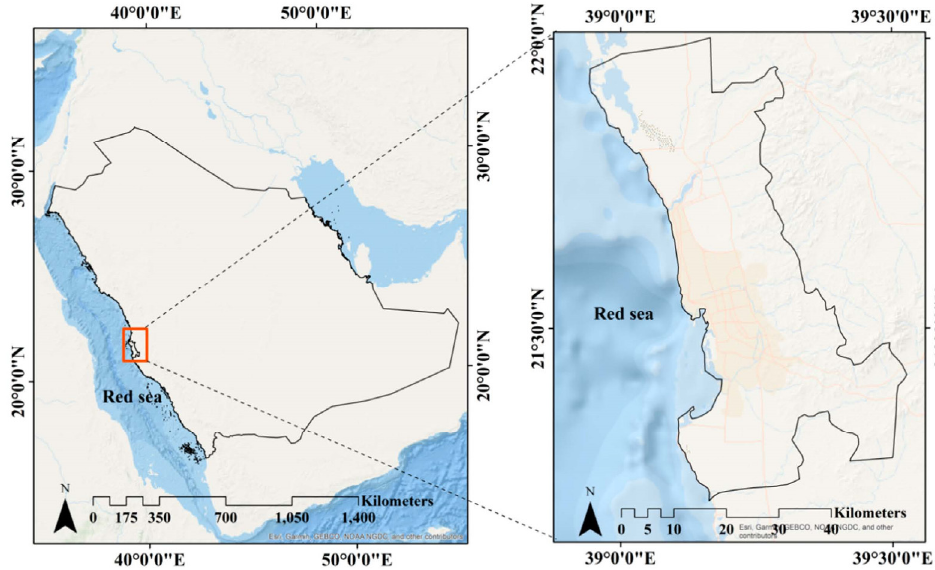
Figure 1. Location map of the study area (Jeddah megacity in Saudi Arabia).